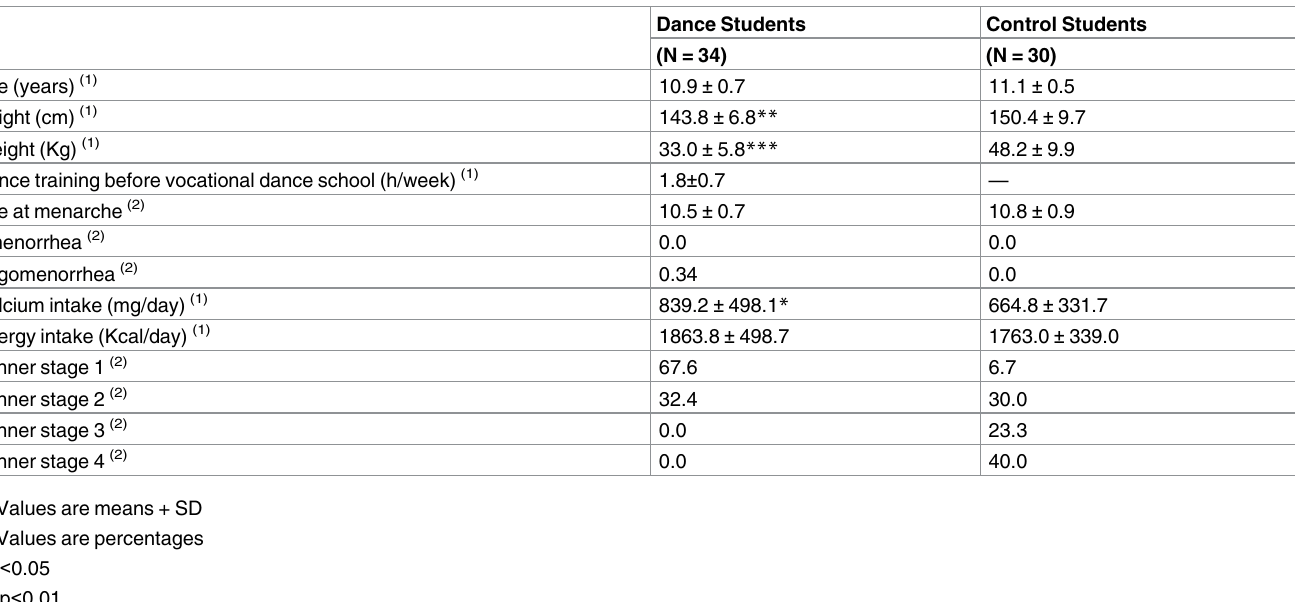
Table 2. Participant